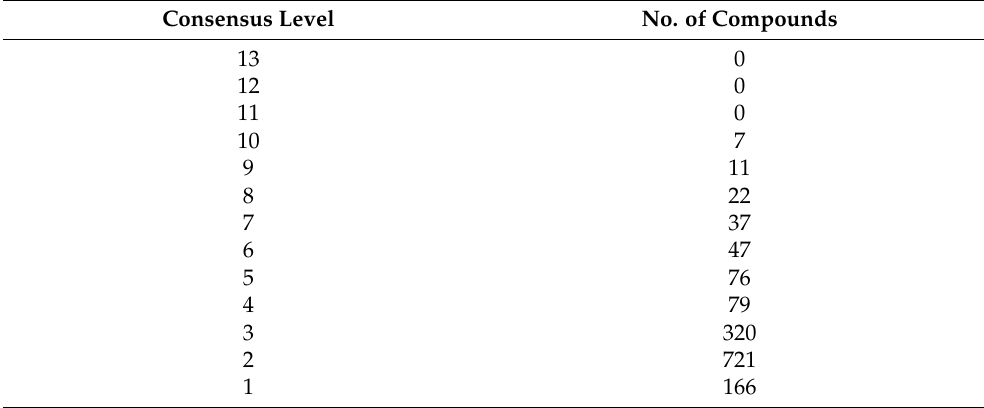
Table 2. Consensus docking